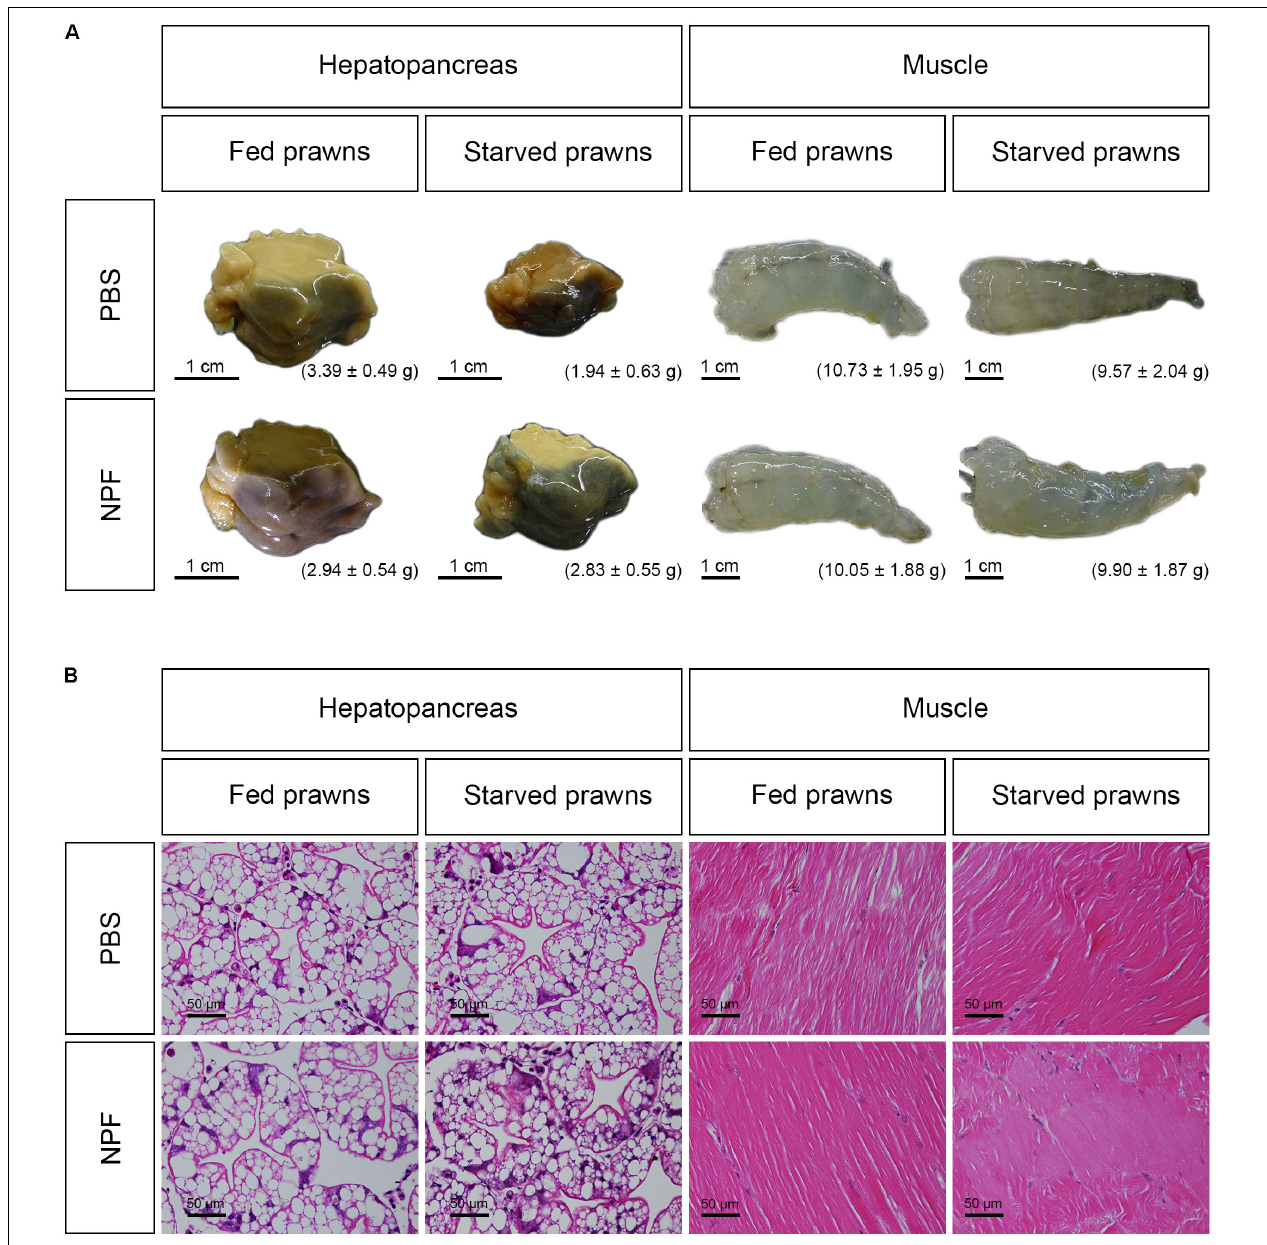
FIGURE 2 | Effects of neuropeptide F and starvation on the structure of M. rosenbergii hepatopancreas and muscle at day 8. (A) Macroscopic pictures of the hepatopancreas and muscle (B) Photomicrographs of the hepatopancreas and